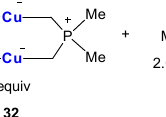
Figure 4. Molecular structure of 30 ; drawn based on